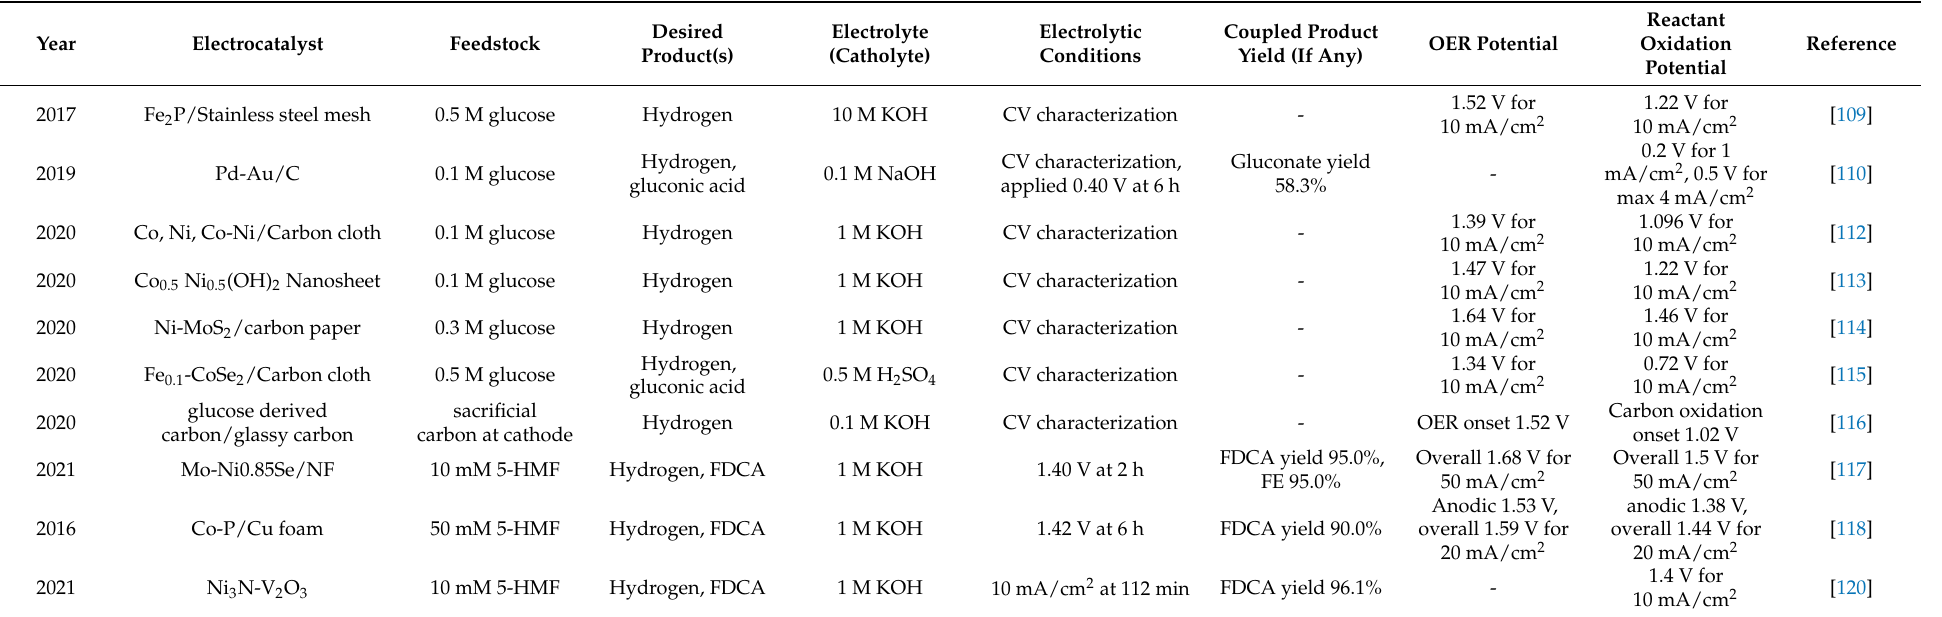
Table 3. Studies investigating evolution of hydrogen coupled with biomass